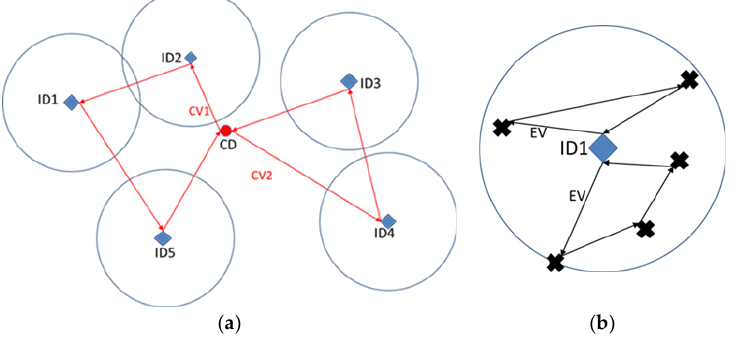
Figure 1. ( a ) Strategy with intermediate depots assuming customers are in the range of IDs. ( b ) Cus- tomers assigned and routes generated at